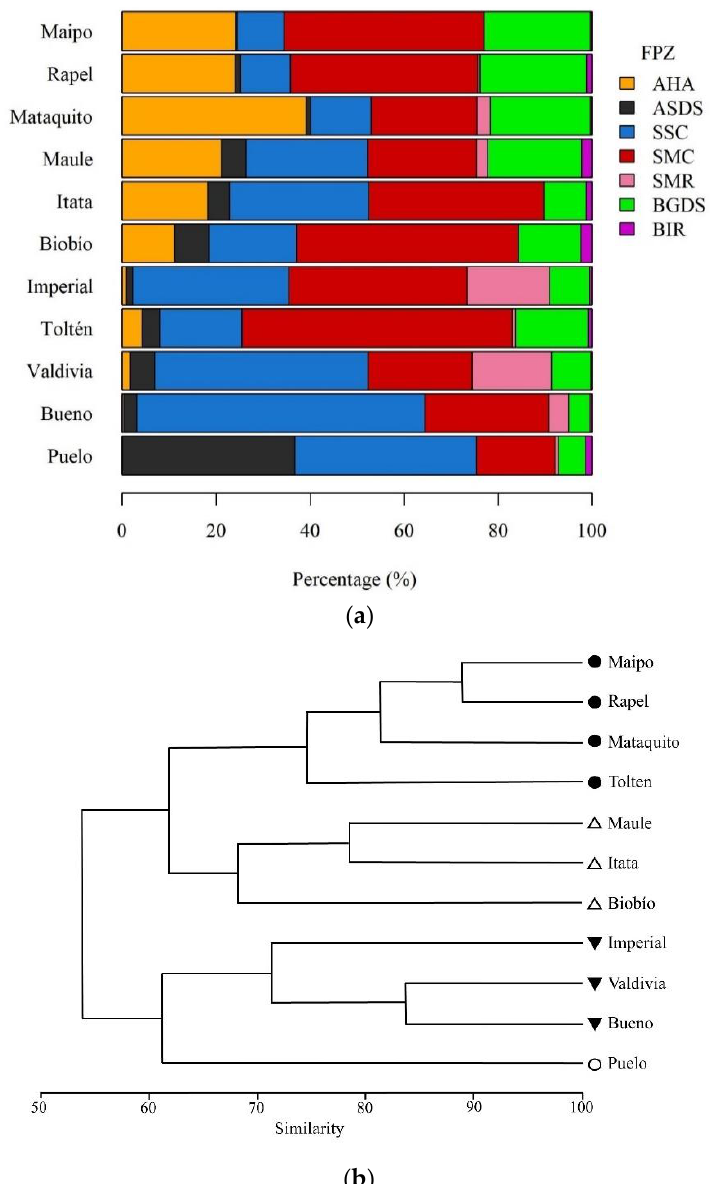
Figure 5. ( a ) Proportion of riverine FPZs in each river basin (ordered from North to South). ( b ) Sim- ilarity among river basins based on their geomorphic characteristics. Symbols represent clusters at 65% similarity.